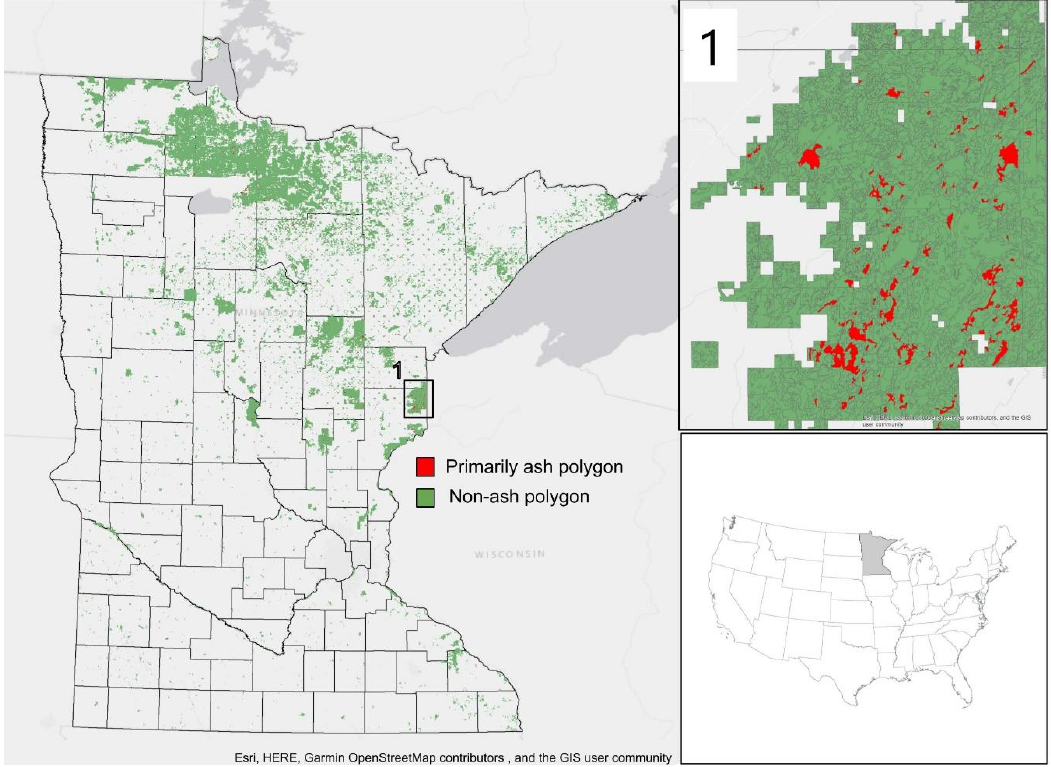
Figure 1. Illustration of the presence and absence of ash stands based on the Minnesota’s Forest Inventory Management polygon database. Inset displays an example of diverse Minnesota forests that transition from non-ash to ash-dominated. Table 1. RandomForest data inputs for classifying ash presence and absence in Minnesota,